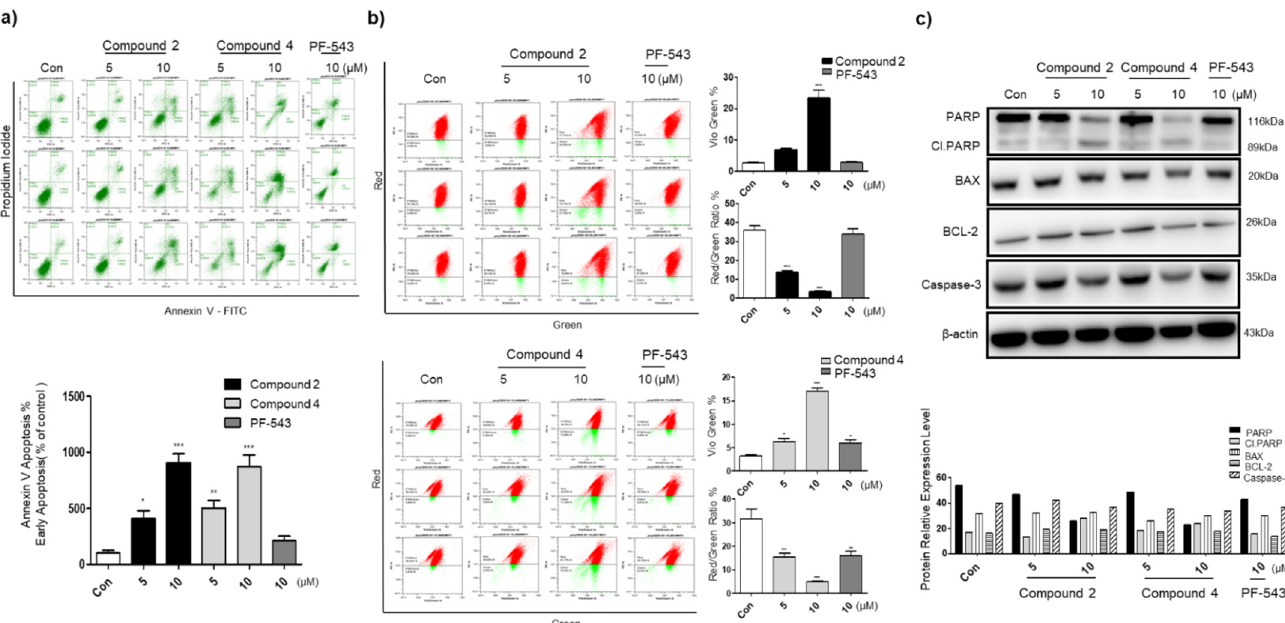
Figure 4. Effects of Compounds 2 and 4 on apoptosis and mitochondrial membrane potential in A549 cells; ( a ) A549 cells were treated with Compounds 2 , 4 and PF-543 of the desired concentration, and apoptosis analysis was performed with annexin V-FITC assay; ( b ) The mitochondrial outer membrane potential was measured using a JC-10 dye and analyzed by the flow cytometer; ( c ) The expression of apoptosis pathway proteins was observed after 24 h treatment with PF-543 and PF-543 derivatives at concentrations of 5 and 10 µ M in A549 cells. β -actin was used as the loading control. Western blots are representative of three independent experiments. Data are expressed as the mean ± S.D. * p < 0.05, ** p < 0.01, and *** p < 0.001 compared with control group.